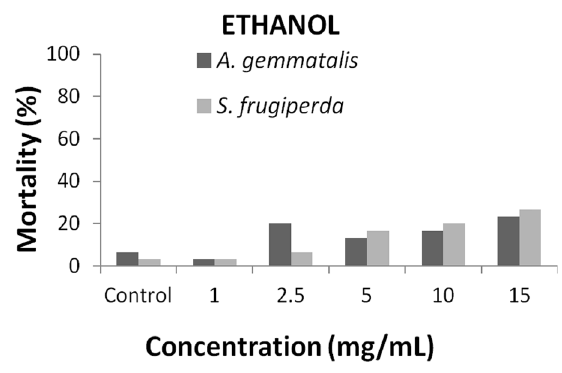
Figure 1 - Cumulative mortality of Anticarsia gemmatalis and Spodoptera frugiperda fed with artificial diet containing: a ) hexane, b ) ethyl acetate, and c ) ethanol extracts of Piper aduncum leaves. *Averages mortality differs in relation to control as determined by Tukey test